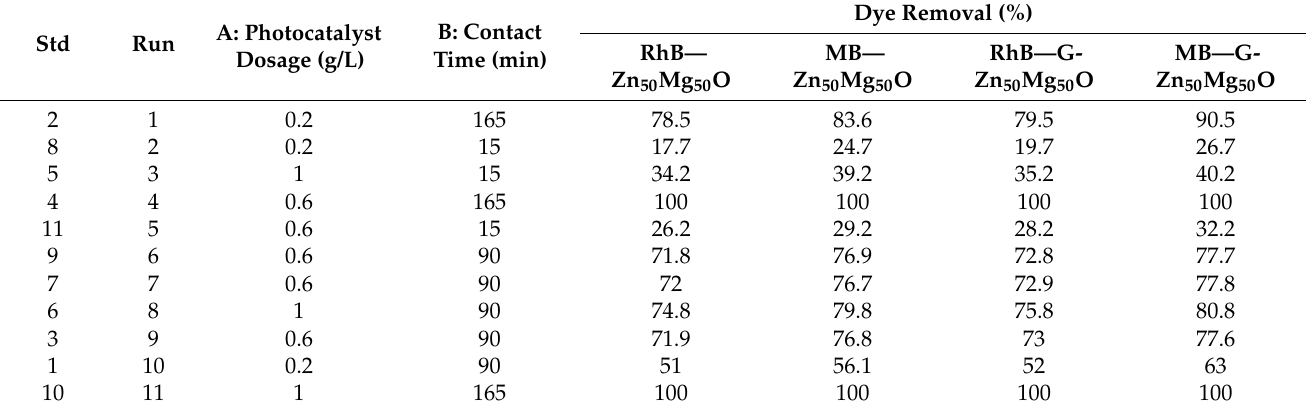
Table 2. Box–Wilson design matrix for photocatalytic removal of dyes using